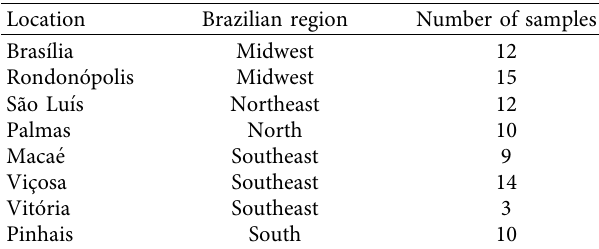
Table 1: Location, Brazilian region, and number of water samples analyzed at each